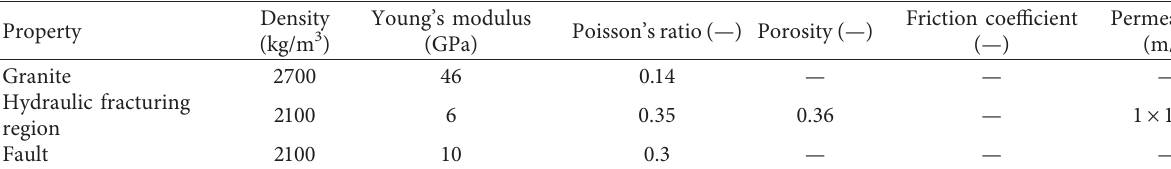
Table 1: Physical parameters of the rock mass.